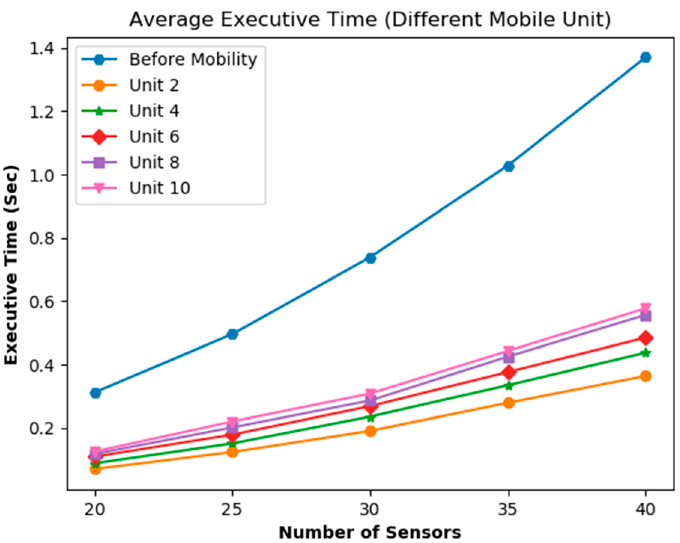
Figure 11. The impact of different mobility units and average execution time for search most and remove useless (SMRU) strategy to adjust the position of chargers after sensor mobility.